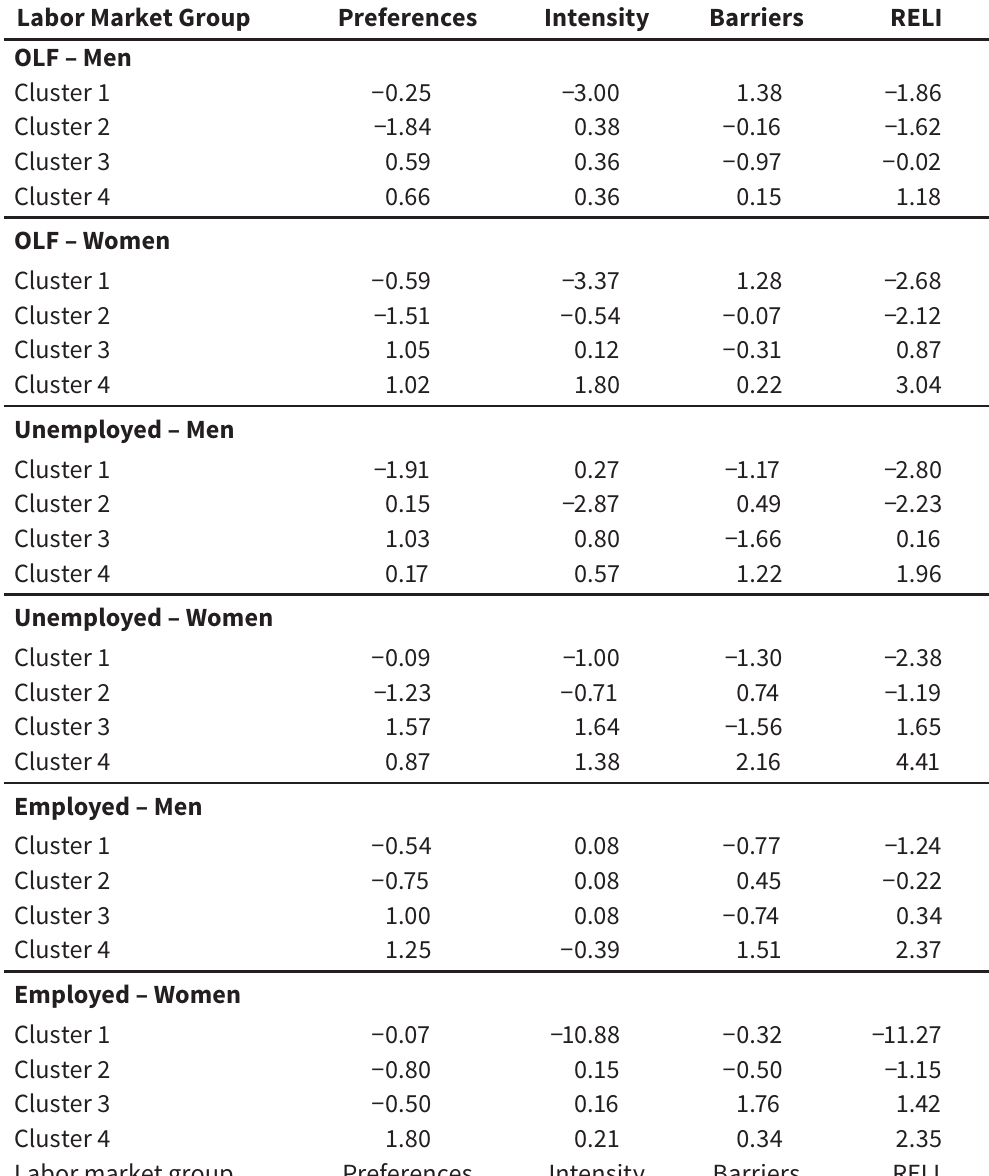
Engagement levels of clusters Labor Market Group